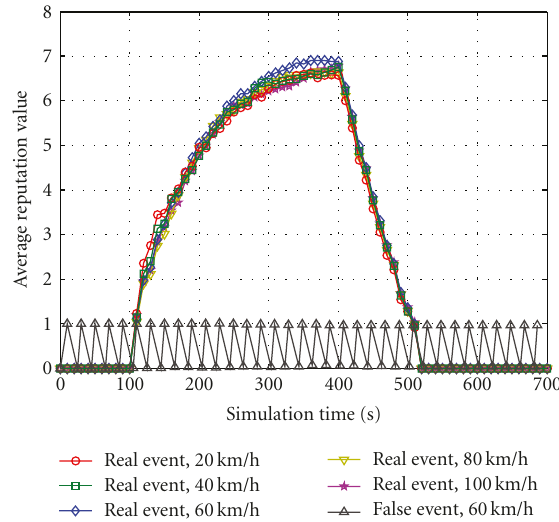
Figure 10: The comparison of average reputation value between a real event and a false